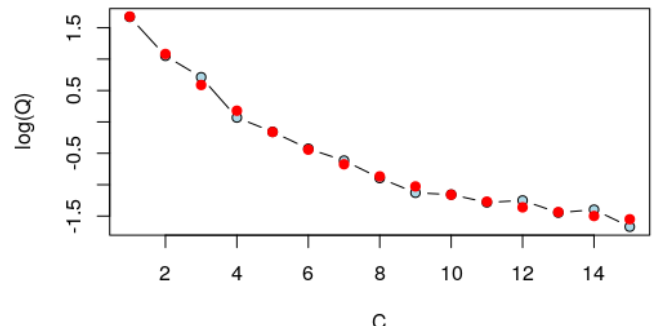
Figure 4. Observations in blue, approximation in